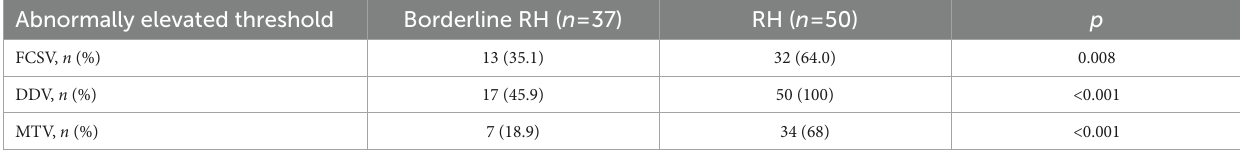
TABLE 4 Comparison of the occurrence of each abnormally elevated rectal sensory threshold between Borderline RH and RH groups. Abnormally elevated threshold Borderline RH ( n =